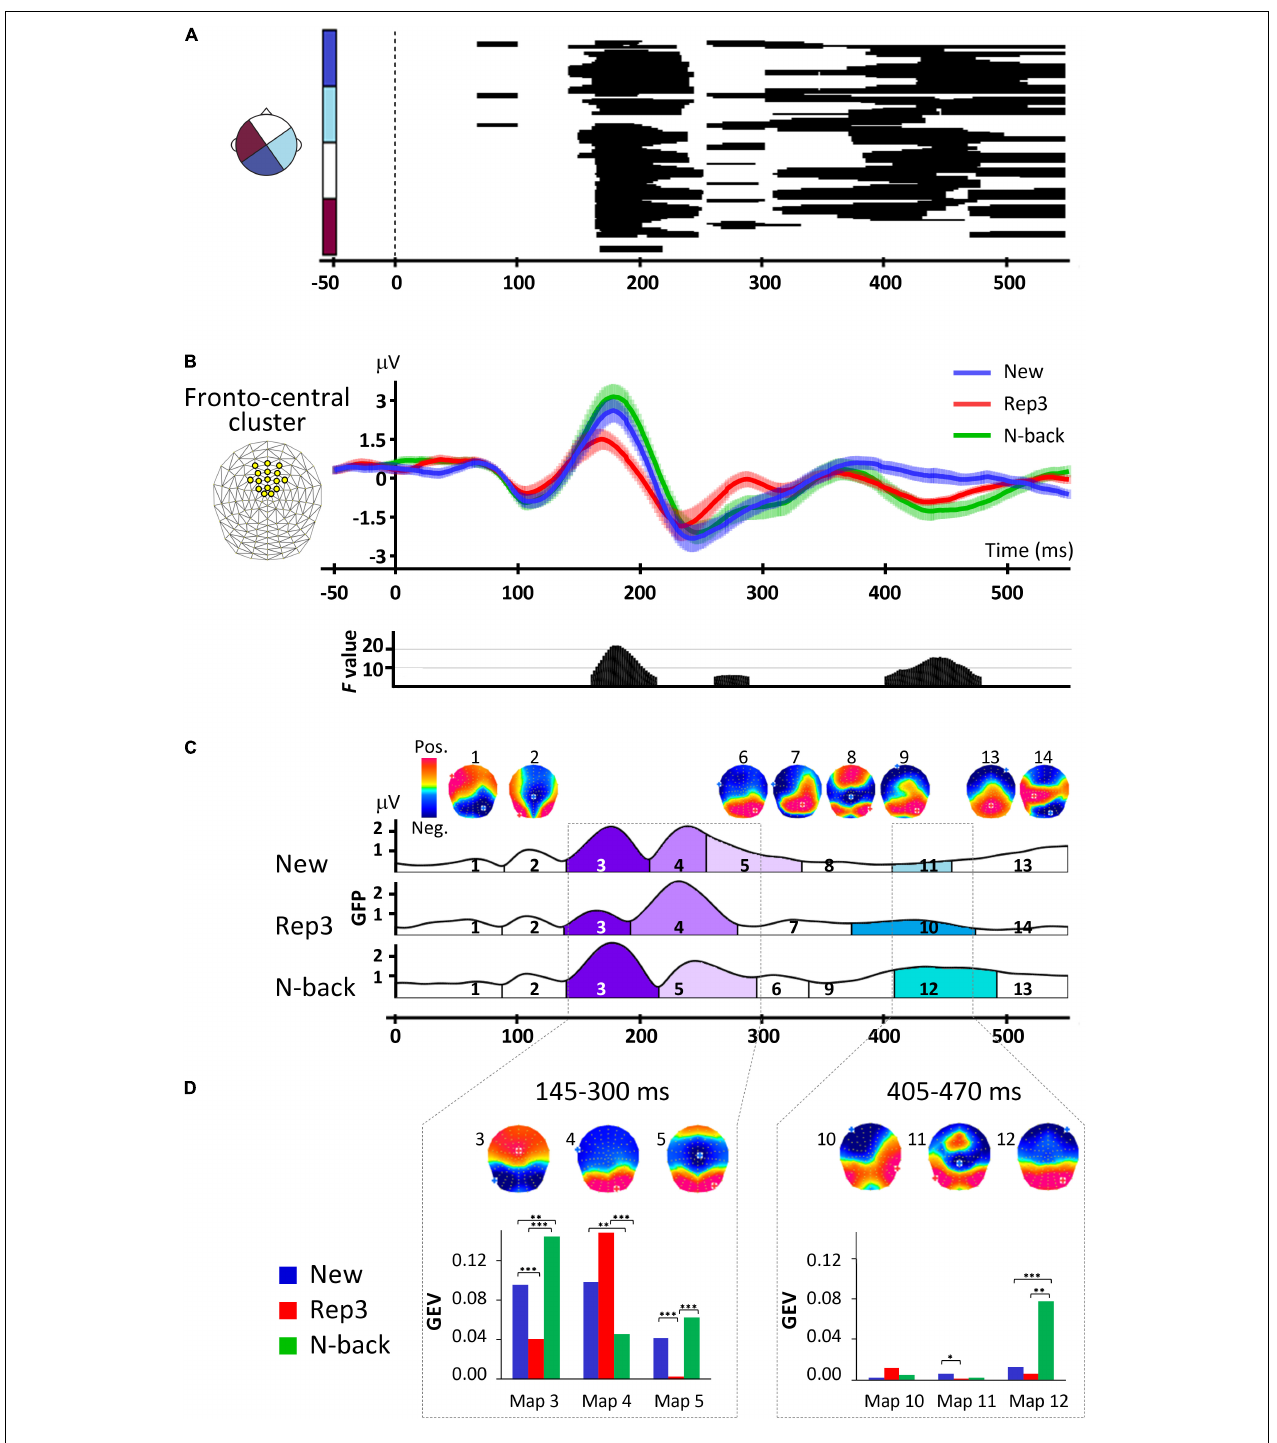
FIGURE 2 | ERP analyses. (A) Amplitude differences over all scalp electrodes across time and conditions revealed by one-way repeated measures ANOVAs, with factor stimulus (New, Rep3, N-back). The x axis shows time (ms) and y axis displays the 128 electrodes. The black horizontal bars indicate where significant main effects occurred with p < 0.005, lasting for at least 30 ms. (B) Orienting waveforms analysis over a fronto-central cluster of 16 electrodes indicated on the upper left. The lower panel displays the F -value of the main effects of one-way repeated measures ANOVA over the cluster with the factor of stimulus type (New, Rep3, N-back) revealing three periods of significant amplitude differences. (C) Spatiotemporal analysis. Temporal distribution of stable electric field topographies in New, Rep3 and N-back conditions and their corresponding cortical maps. The curves indicate the GFP (Global field power). (D) Statistics of fitting the group-averaged topographies to single subject ERPs. Bar graphs display the GEV (Global Explained Variance), the measure of how well a given map in a given period of time represents individual data. ∗ p < 0.05, ∗∗ p < 0.01, ∗∗∗ p < 0.005.